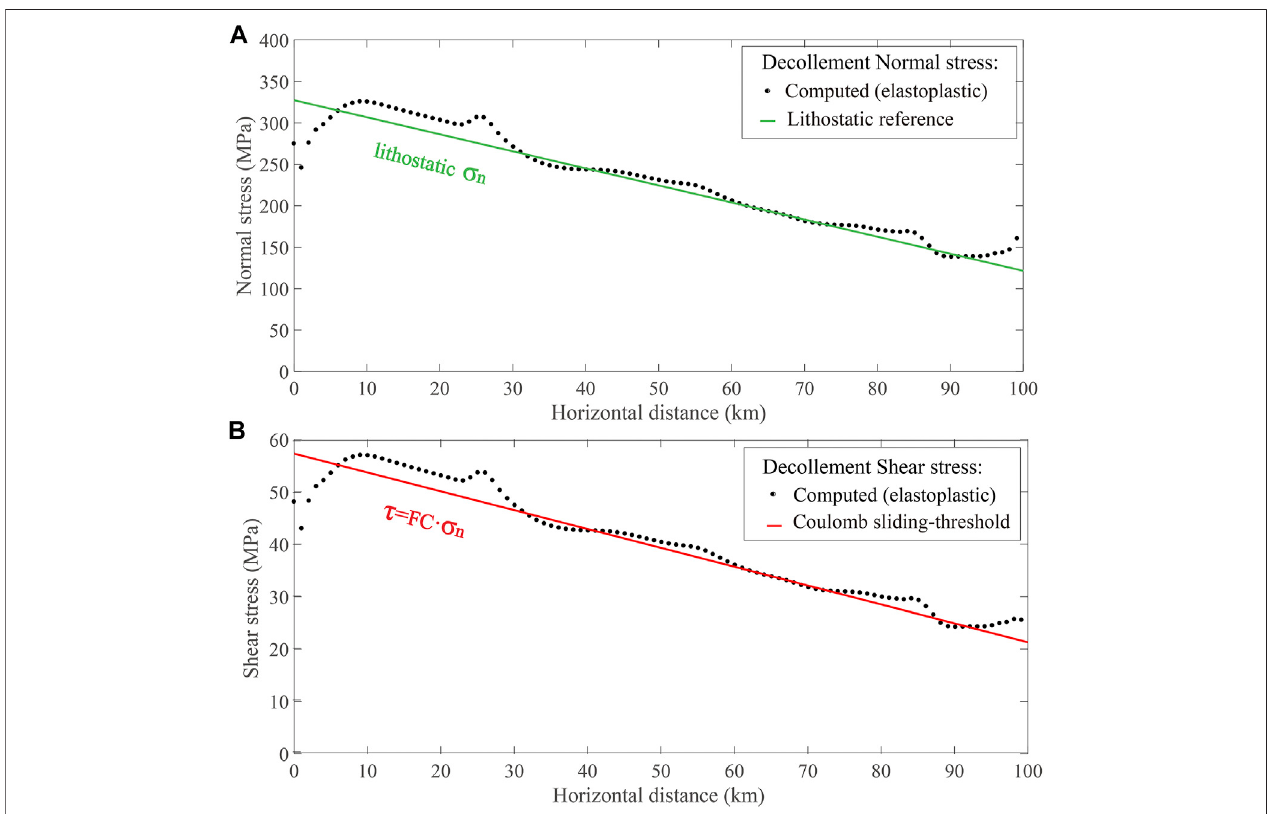
FIGURE7| Final-statenormalandshearstressesonbottomdecollementafter6.6 km oftectonicshorteninginreferencemodel,plotted versus horizontaldistance ofitsundeformedstate. (A) Computed normalstress(dots)ofelastic-plasticmodeland theoretical normalstress(green line)fromareferencehomogeneouslydeformed wedge with same parameters (these are compressive stresses); (B) computed shear stress (dots) and theoretical reference (red line) (these are up-the-slope directed). Elastic-plastic-dynamics normal stress is dominated by lithostatic-column weight (which projects onto decollement), and dynamic shear stress is very close to Coulomb sliding-threshold stress (see Appendix SA ). Short-length scale and small-amplitude variations of computed stresses are result of dynamically created topography, plastic deformation zones, and differential slip-on decollement, resulting from general elastic-plastic response to horizontal shortening.